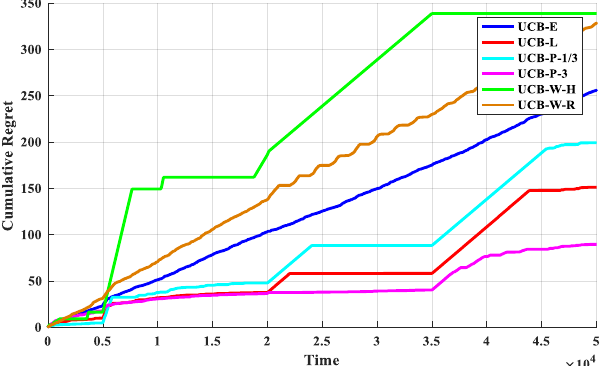
Figure 5. The cumulative regret for the O-D-UCB policies with different discount functions in dataset b.